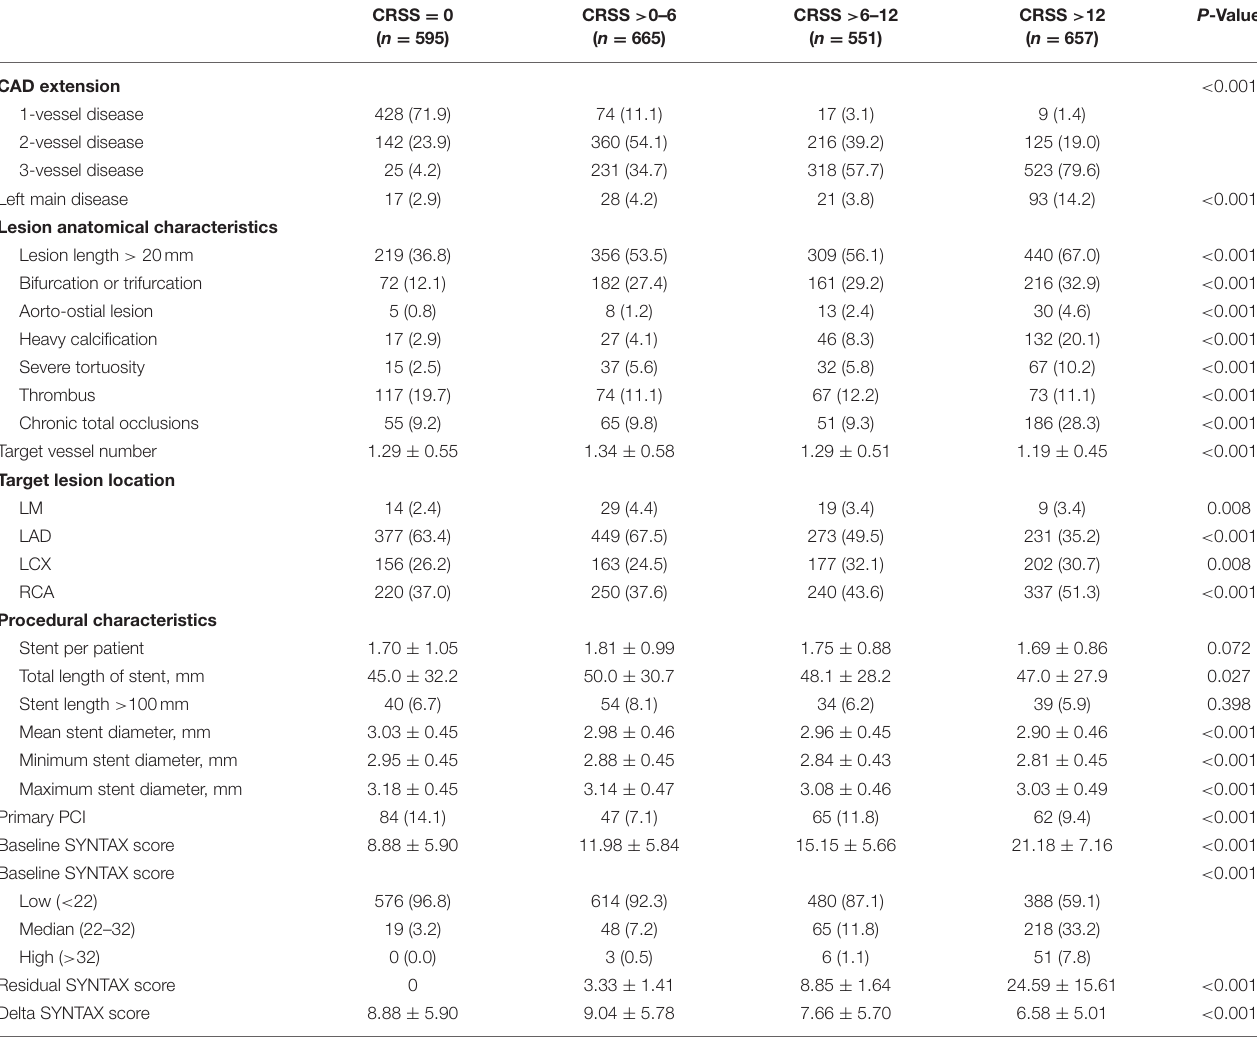
TABLE 2 | Angiographic and procedural characteristics.